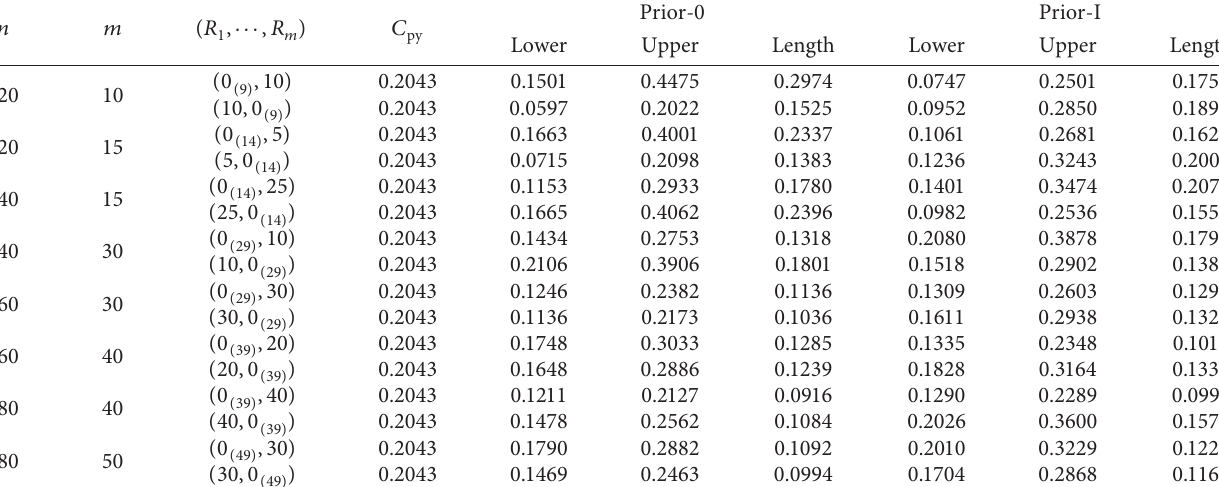
Table 9: True value of C and its 95% CRIs when α � 7 . 0 , θ � 4 . 0 , and c � 0 . py